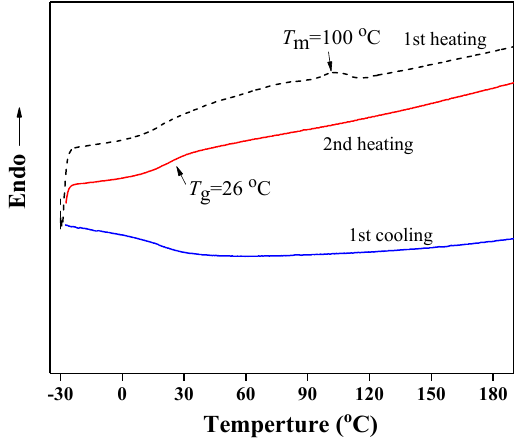
Figure 4. Differential scanning calorimetry (DSC) curves of the obtained PBLG-PPG-PBLG film during heating and cooling.